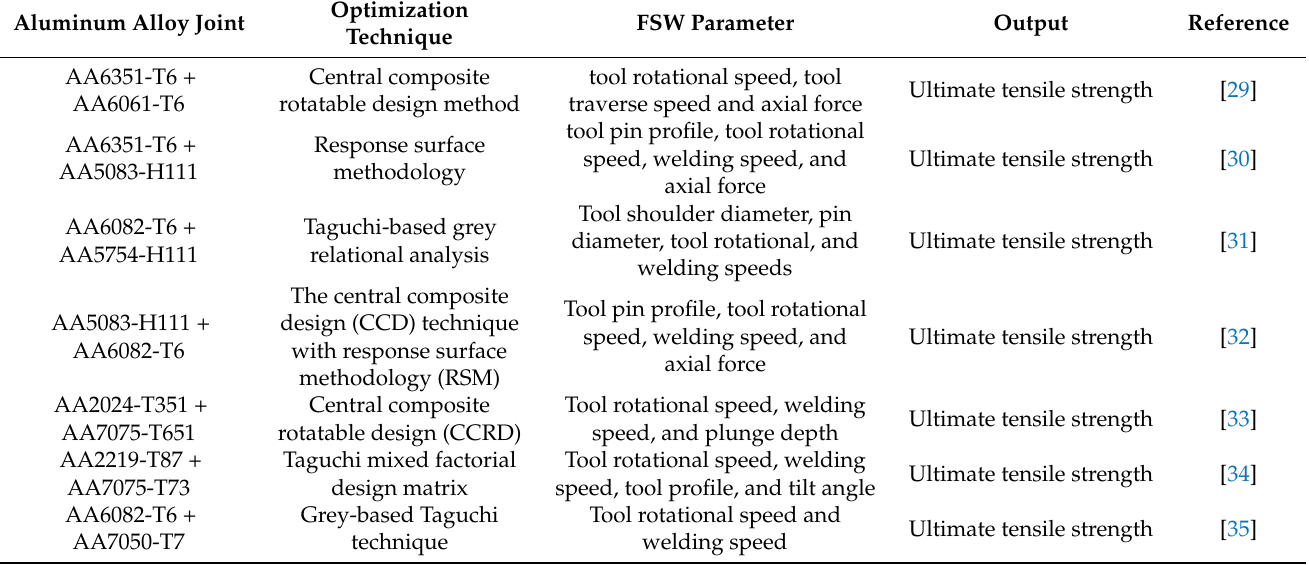
Table 1. Summary of optimization of FSW process parameters at various dissimilar aluminum joints.